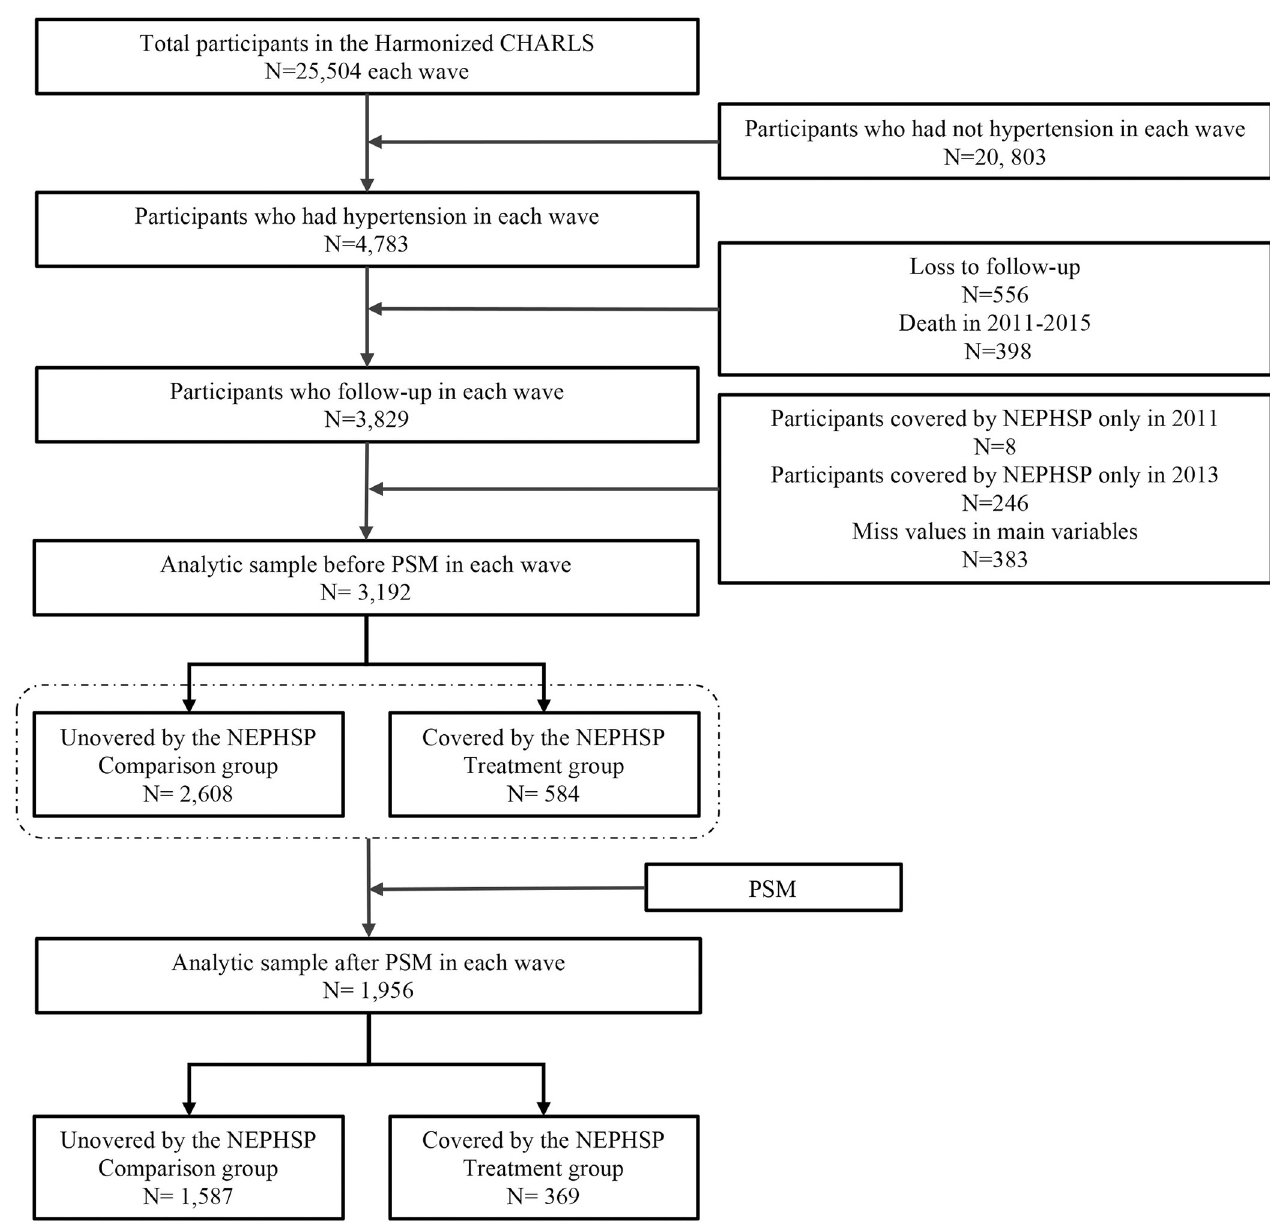
Fig 1. Flow chart of the